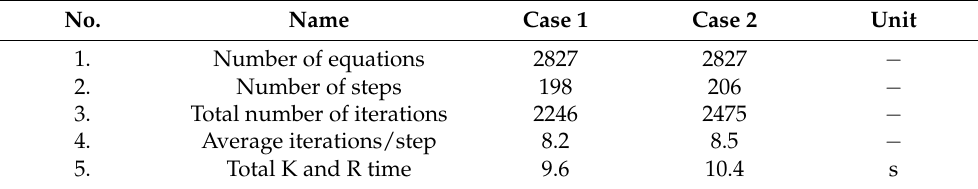
Table 9. AceFEM—simulation report of Case 1 vs. Case 2